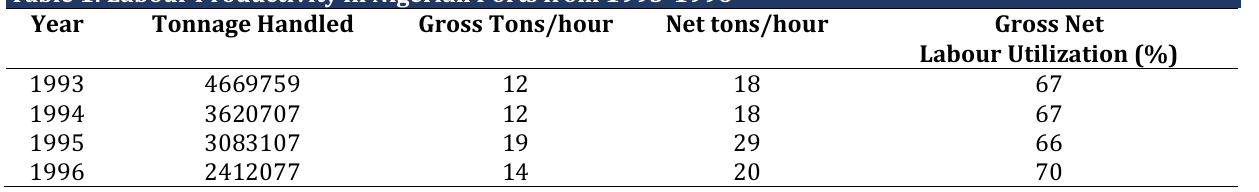
Table 1: Labour Productivity in Nigerian Ports from